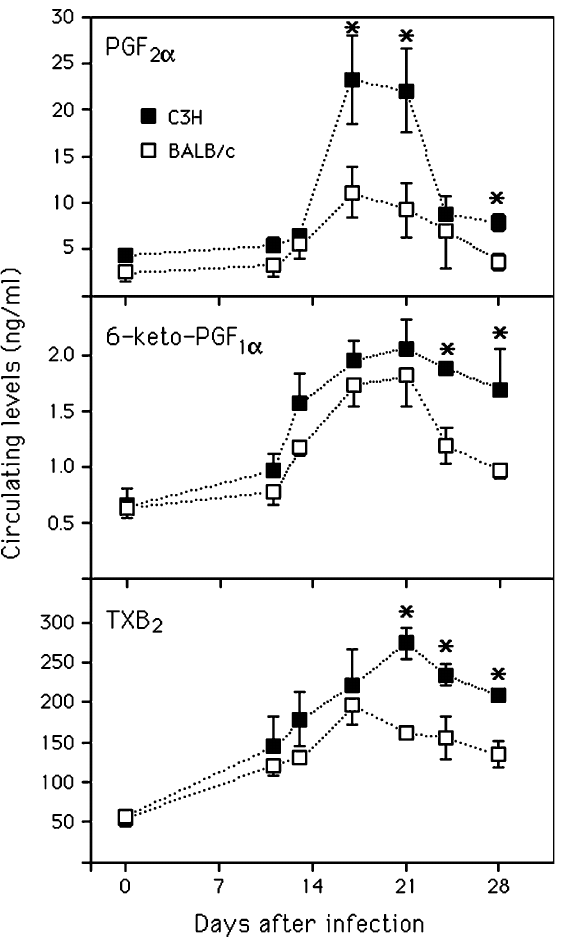
FIG. 2. Circulating levels of COX metabolites in C3H and BALB/c mice acutely infected with T.cruzi. Levels of PGF 2 a , 6- keto-PGF 1 a and TXB 2 were determined in sera collected at the days p.i. indicated. The concentrations were higher than controls on the third and fourth week p.i. (p B / 0.05, t-test). Means 9 / standard errors of 4 (cid:1) / 6 mice/group are shown. *Differences between mouse strains are significant (p B / 0.05,